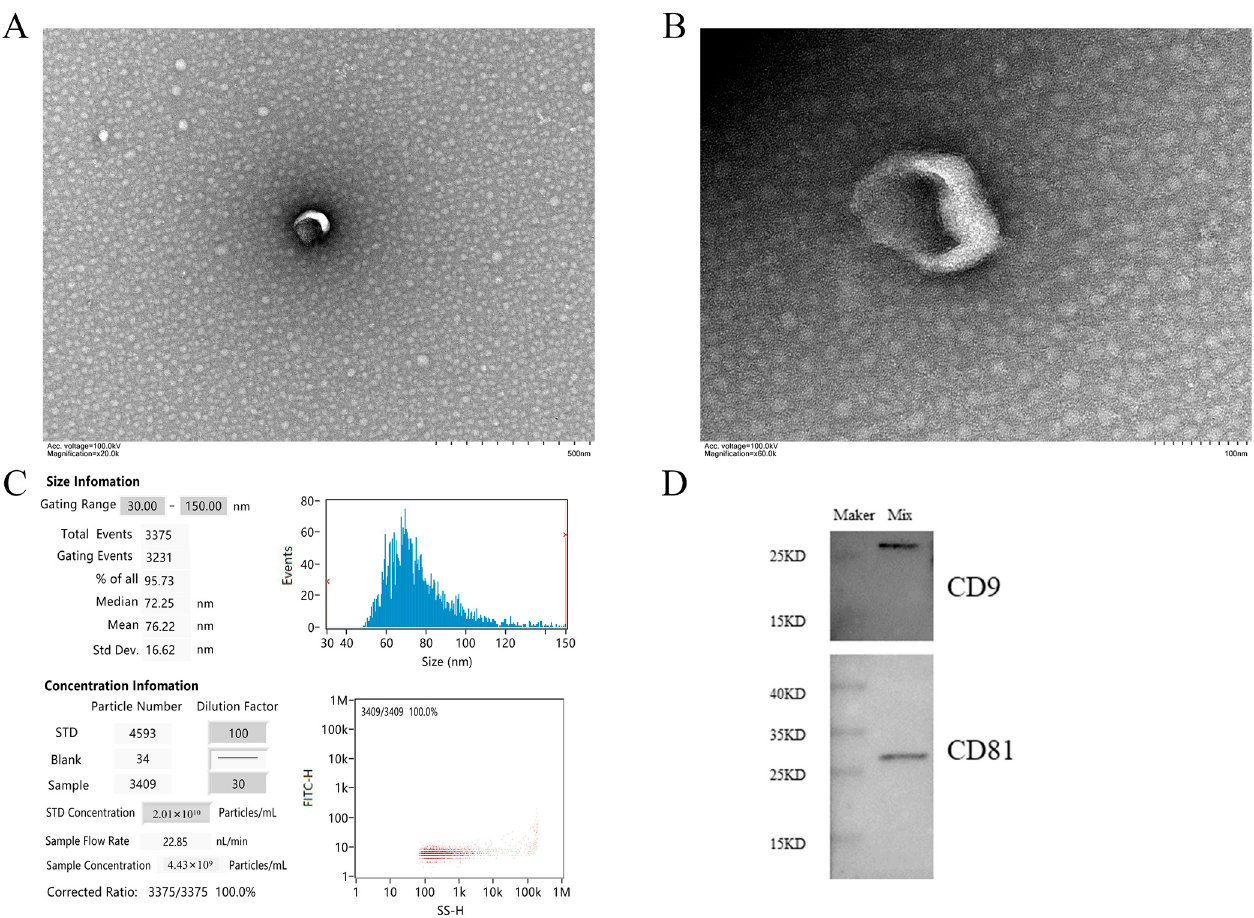
Figure 1. Main characteristics of serum exosomes. ( A ) and ( B ) show the morphological characteris- tics of vesicles by TEM. Scale bars are 500 nm and 100 nm, respectively. ( C ) NTA shows the diameter and concentration of most vesicles. ( D ) Western blot showed the presence of exosome markers CD81 and CD9 in serum exosomes. Note: Mix in WB results is the sample mixed suspension isolated by the exoEasy Maxi